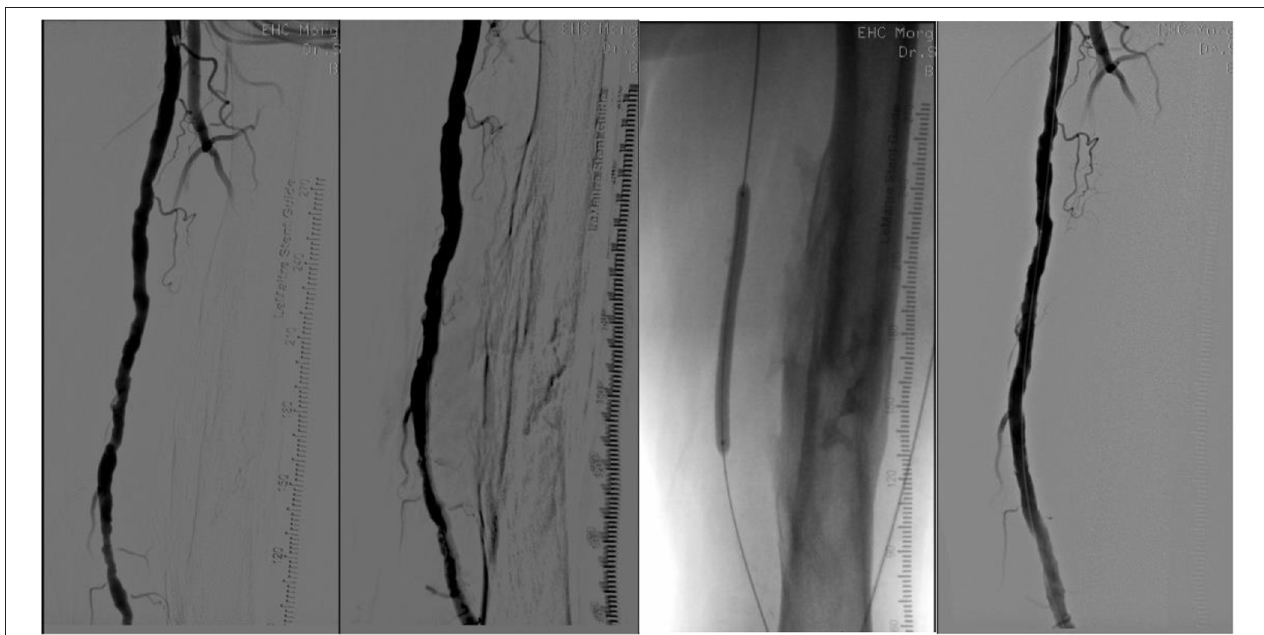
FIGURE 2 | From left to right. (1) Long superficial femoral artery lesion; (2) After directional atherectomy, filter is in the popliteal artery (not seen); (3) DEB angioplasty; (4) Final